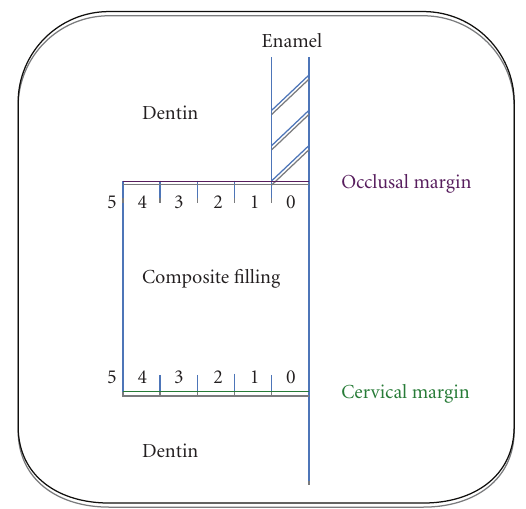
Figure 2: Illustration of the 6-point severity scale used to evaluate the microleakage at the margins of the restorations (occlusal and cervical